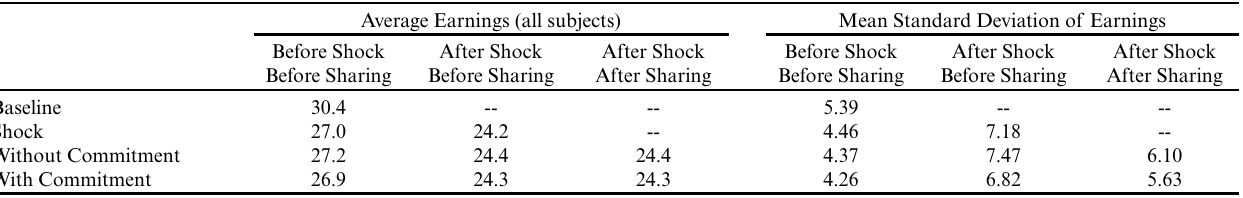
Table 3 . Decomposition of earnings.